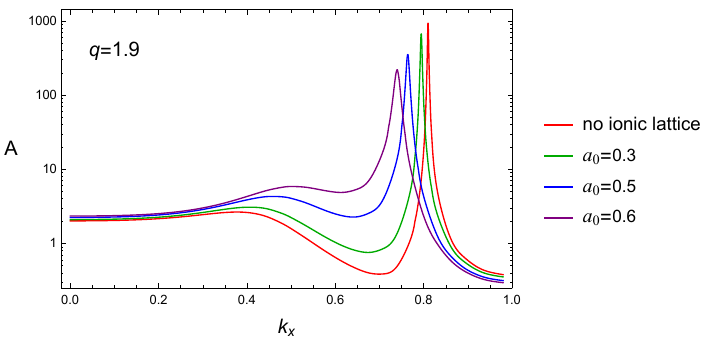
Figure 12 . The MDF along the k x -axis for di(cid:11)erent values of the amplitude of the ionic lattice for q = 1 : 9. The (cid:12)rst Brillouin zone boundary is at k x = 1. The inner Fermi surface dissolves as the strength of the ionic lattice increases.